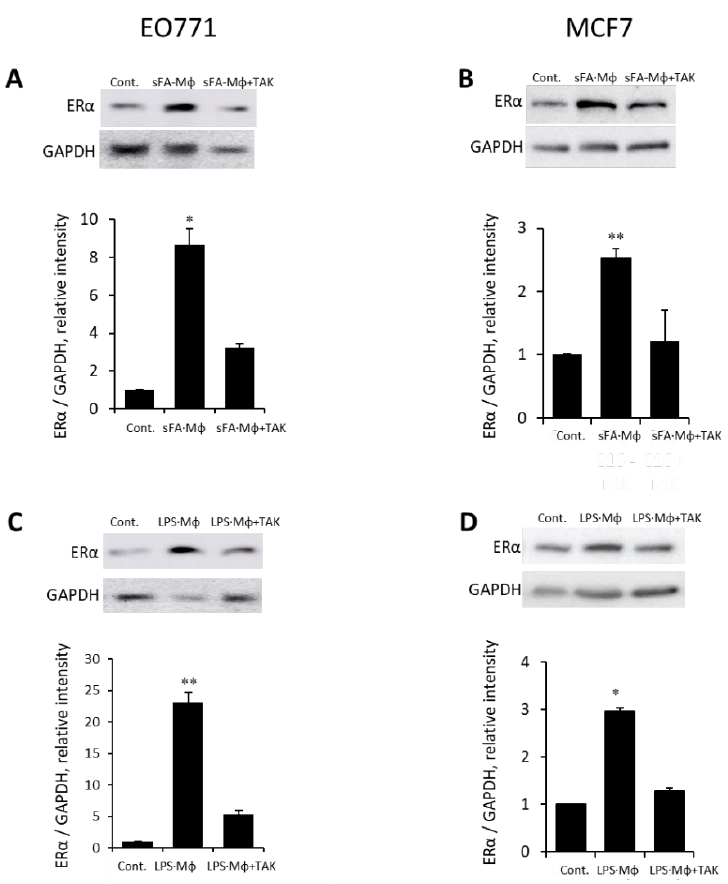
Figure 3. Ability of macrophages to upregulate ER expression in BC cells in response to stimulation by obese milieu components depends on TLR4 signaling. ( A , B ). Mouse E0771 ( A ) and human MCF7 ( B ) BC cells either remained untreated (Cont.) or were incubated (24 h, 37 °C) with medium conditioned by macrophages stimulated with 200 µM SFA (i.e., palmitic acid), alone (SFA·M ϕ ) or in the presence of 30 µM of TLR4-specific inhibitor TAK-242 (SFA·M ϕ +TAK). ER α protein levels were determined by immunoblotting (top) and quantified using ImageJ software (bottom); the intensity ratio for ER α / GAPDH is shown. ( C , D ). Macrophages stimulated by conditions mimicking metabolic endotoxemia upregulated ERα expression in BC cells. E0771 ( C ) and MCF7 ( D ) cells were either remained untreated (Cont.) or were incubated (24 h, 37 °C) with medium conditioned by macrophages stimulated by 0.1 ng/mL LPS alone (LPS·M ϕ ) or in the presence of 30 µM of TLR4-specific inhibitor TAK-242 (LPS·M ϕ +TAK). ER α protein levels were determined by immunoblotting (top) and quantified using ImageJ software (bottom). The intensity ratio for ER α / GAPDH is shown. The data are representative of 3 independent experiments; error bars represent ± SD. * p < 0.007; ** p < 0.0009.